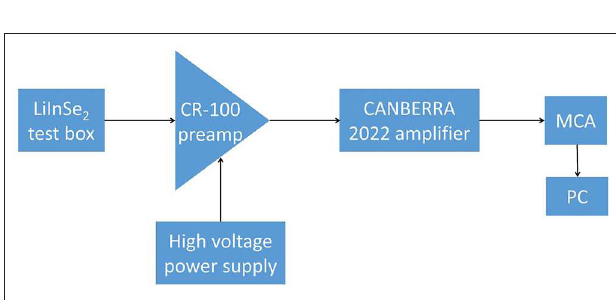
FIGURE 5 | Schematic of the detector test